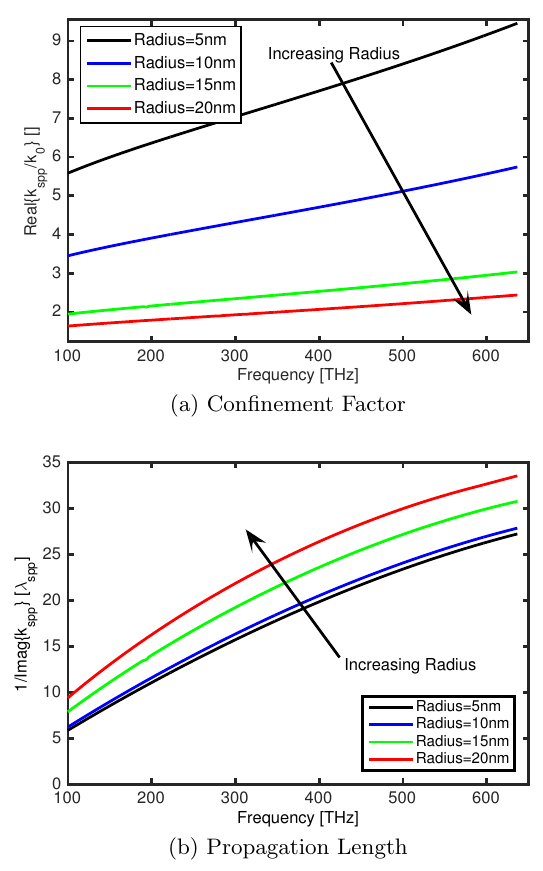
Figure 3: Propagation properties of SPP TM modes on gold